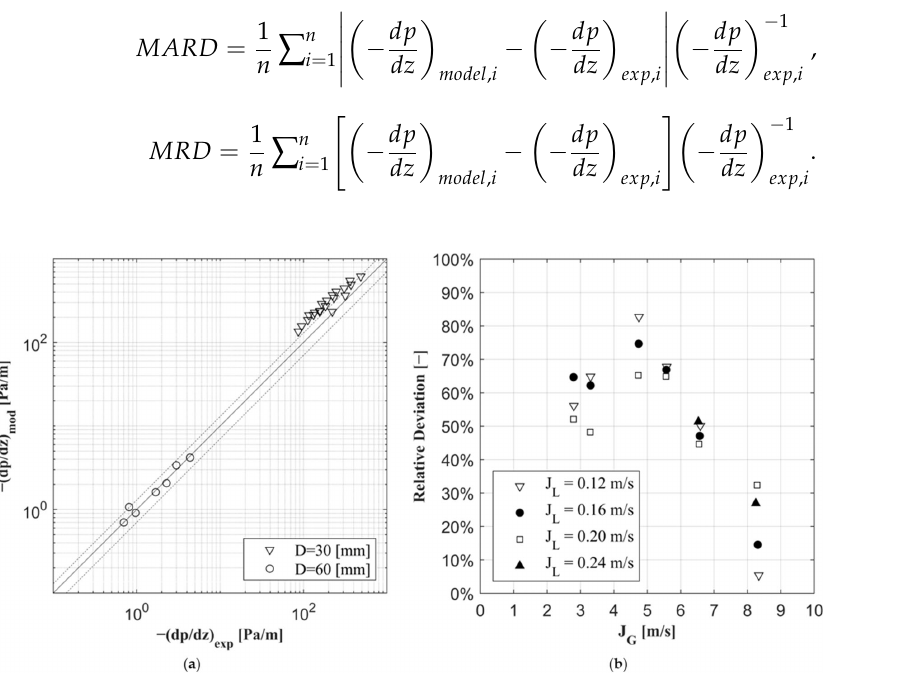
Figure 1. ( a ) OLGA pressure gradient log–log parity plot for 30 mm and 60 mm ID pipeline flows (±30% error range is reported); ( b ) Relative deviation as a function of the gas superficial velocity at constant liquid superficial velocity for the 30 mm ID pipe (the points reported correspond to the flow pattern conditions correctly recognized by OLGA). Table 1. MARD and MRD for the OLGA model for air–water flow.